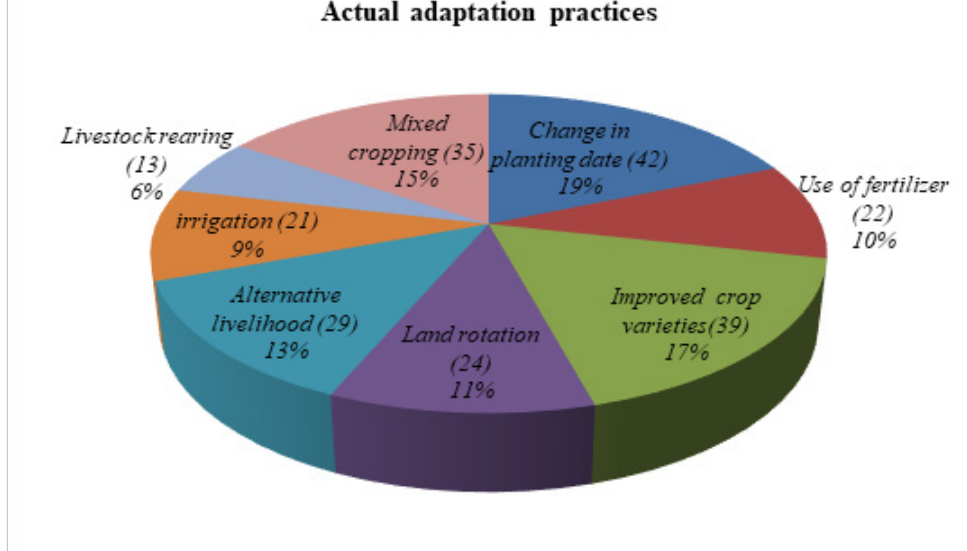
Figure 2: adaptation practices in the study area. Source: field survey